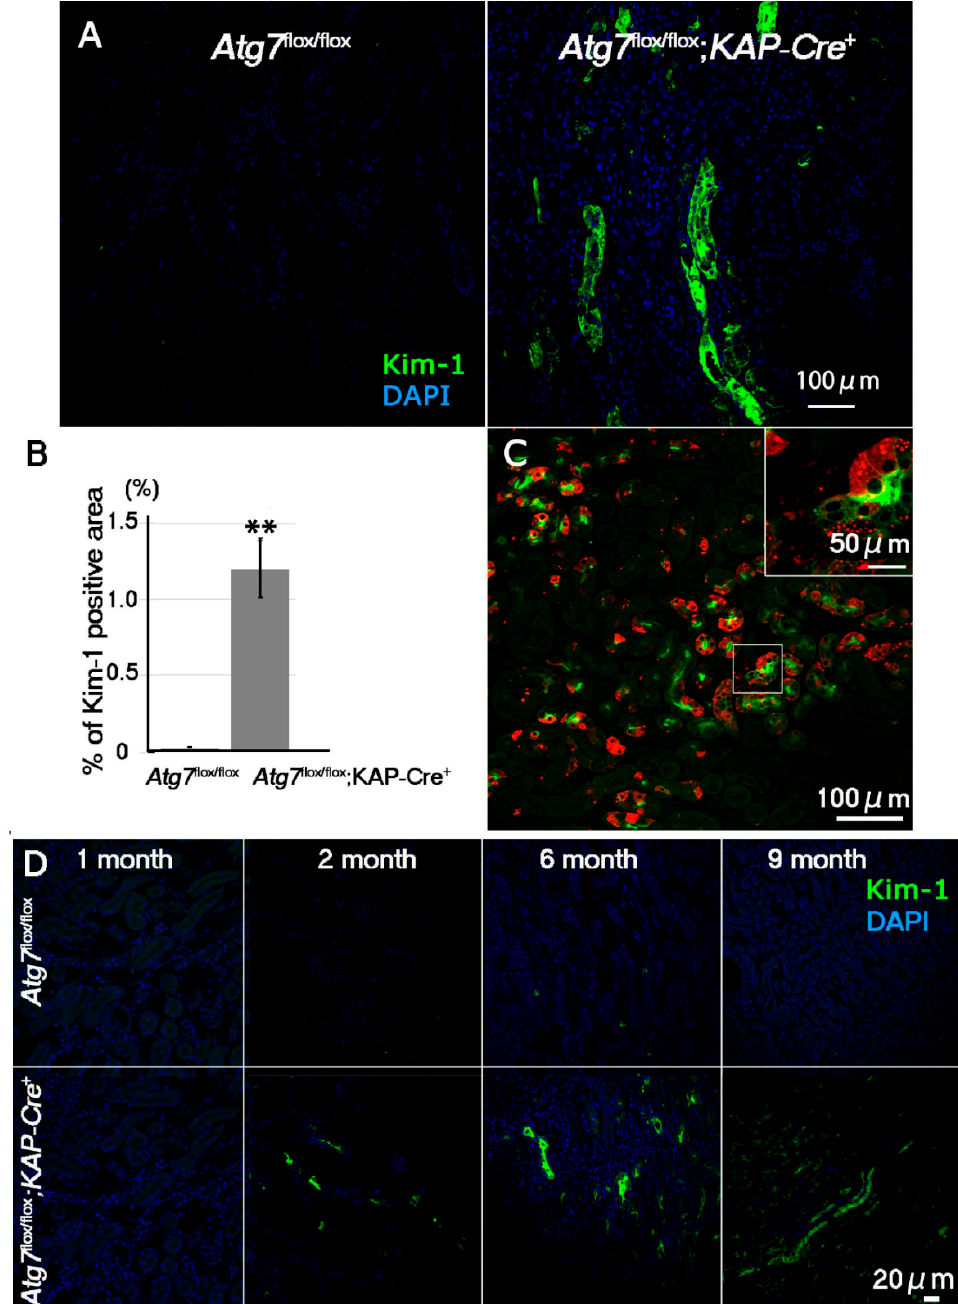
Figure 2. Age-dependent increase of Kim-1, a marker for early kidney injury, in the Atg7 flox / flox ;KAP-Cre + mouse kidney. ( A ) Representative images of Kim-1 immunostaining (green) in the proximal region of the kidneys of 2-month-old Atg7 flox / flox ;KAP-Cre + mice. As a control, Atg7 flox / flox mouse kidneys were used. Nuclei were stained with DAPI (blue). ( B ) Quantification of Kim-1-positive area of 2-month-old Atg7 flox / flox and Atg7 flox / flox ;KAP-Cre + mouse kidneys. Kim-1-positive signals in the cortico-medullary region of 2 month-old Atg7 flox / flox ( n = 4) and Atg7 flox / flox ;KAP-Cre + ( n = 7) mice were estimated by ImageJ software (https: // imagej.nih.gov / ij / index.html) [26]. Statistical analyses were performed using a student’s t -test (** p < 0.03). Data in the graph are expressed as the mean ± SEM. ( C ) Accumulation of Kim-1-positive signals in p62-positive autophagy-deficient renal tubular cells. Renal tubular cells in the cortico-medullary region were detected anti Kim-1 (green) and p62 (Red). ( D ) Age-dependent accumulation of Kim-1 in Atg7 flox / flox ;KAP-Cre + mouse kidney. Kidney samples from 1-, 2-, 6-, and 9-month-old Atg7 flox / flox ;KAP-Cre + (lower) and Atg7 flox / flox (upper) mice were stained with anti-Kim-1 antibody (green).